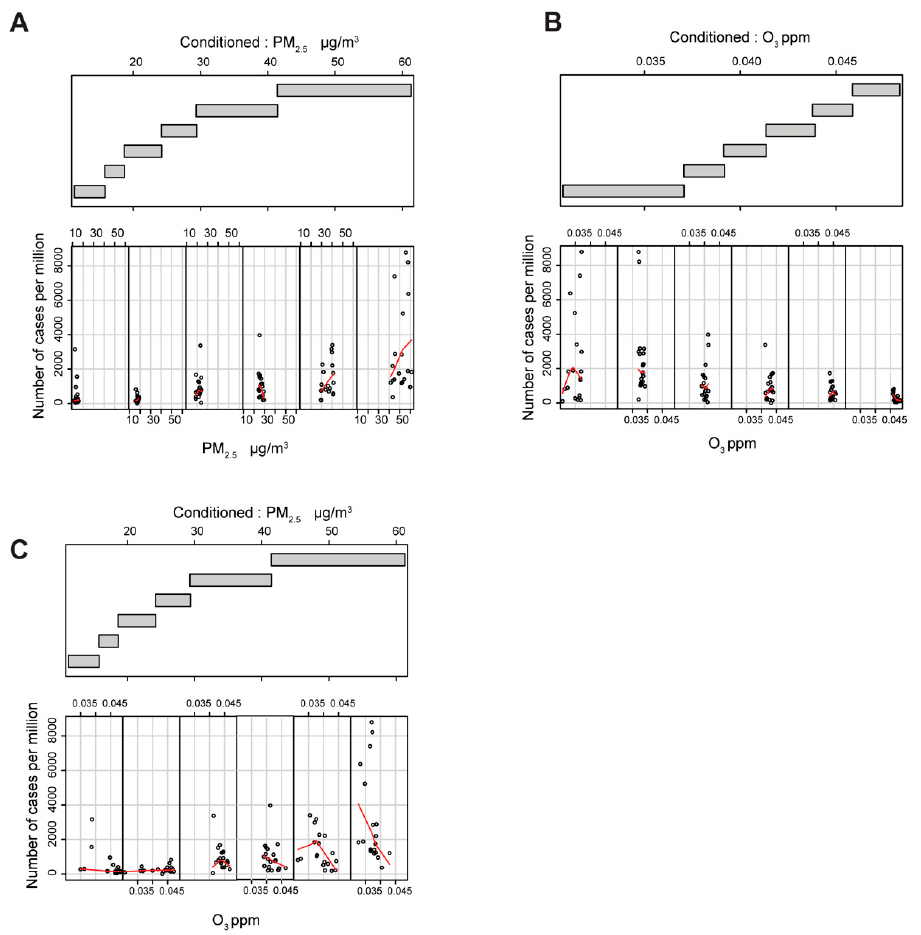
Figure 2. Evaluation of the cross-influence between PM 2.5 and O 3 . Lower panel: the scatter plots between the selected factor and the number of cases per million. The LOESS curve is computed in each scatterplot and shown in red. Each plot is restricted to show datapoints that belong to the provinces that fall in the corresponding range of the conditioning factor. Upper plot: the range of the values that define each level of conditioning. The overlap among the levels is 0.1. ( A ) the scatterplot of PM 2.5 conditioned to PM 2.5 ; ( B ) the scatterplot of O 3 conditioned to O 3 ; ( C ) the scatterplot of O 3 conditioned to PM 2.5 .